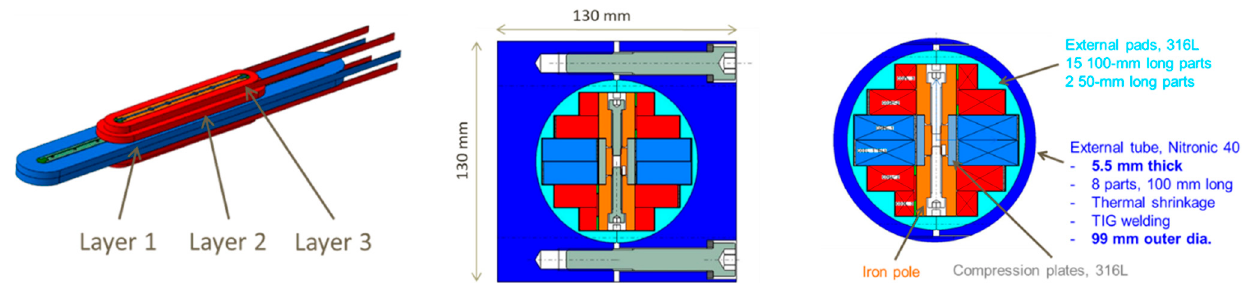
Figure 4. The layout of the EuCARD HTS magnet by CEA. Left: view of the three coil layers. Center: first demountable assembly for the stand-alone test. Right: compact assembly for the test in Fresca2. Courtesy of M. Durante, CEA.